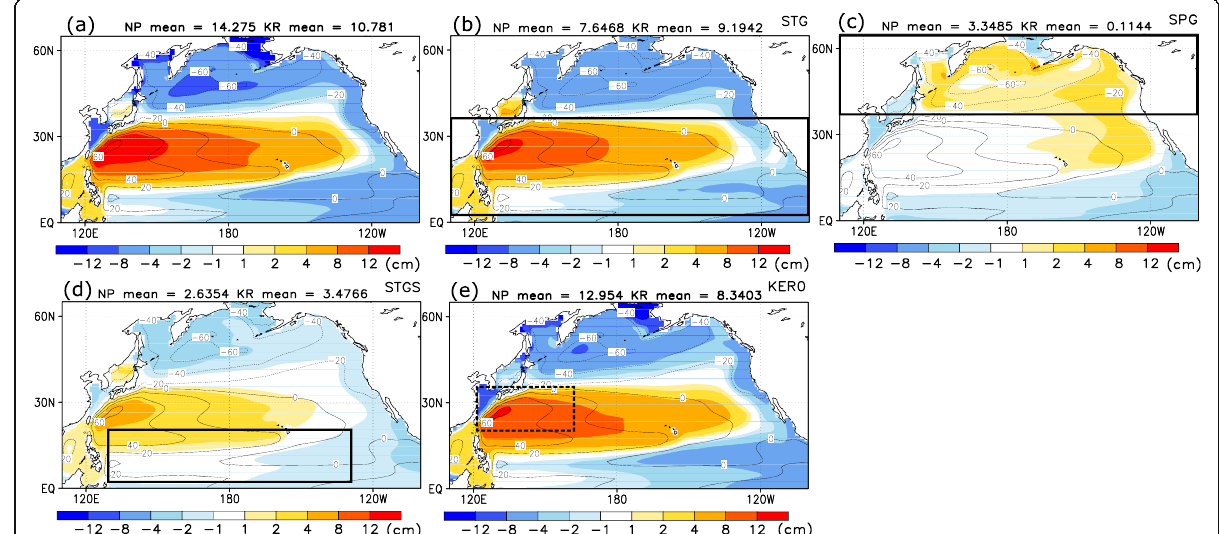
Fig. 6 Thermosteric sea level change (cm) due to the added heat T A ( Δ η TA ) in the faf-heat experiment and in the case when the area to which the application of heat flux is limited to b the subtropical gyre region (4° N – 38° N, 100° E – 100° W), c the subpolar gyre region (38° N – 64° N, 100° E – 100° W), d the southern part of the subtropical gyre (4° N – 20° N, 130° E – 130° W), and e the area excluding the Kuroshio and the Kuroshio numbers on each figure show the basin average of the North Pacific (NP mean) and the area average of the deviation in the Kuroshio Extension recirculation (KR mean). Contours indicate the climatological DSL in piControl. The solid boxes indicate the area given by heat flux perturbation ( b , c ), and the dotted box indicates the area excluding the heat flux perturbation ( e